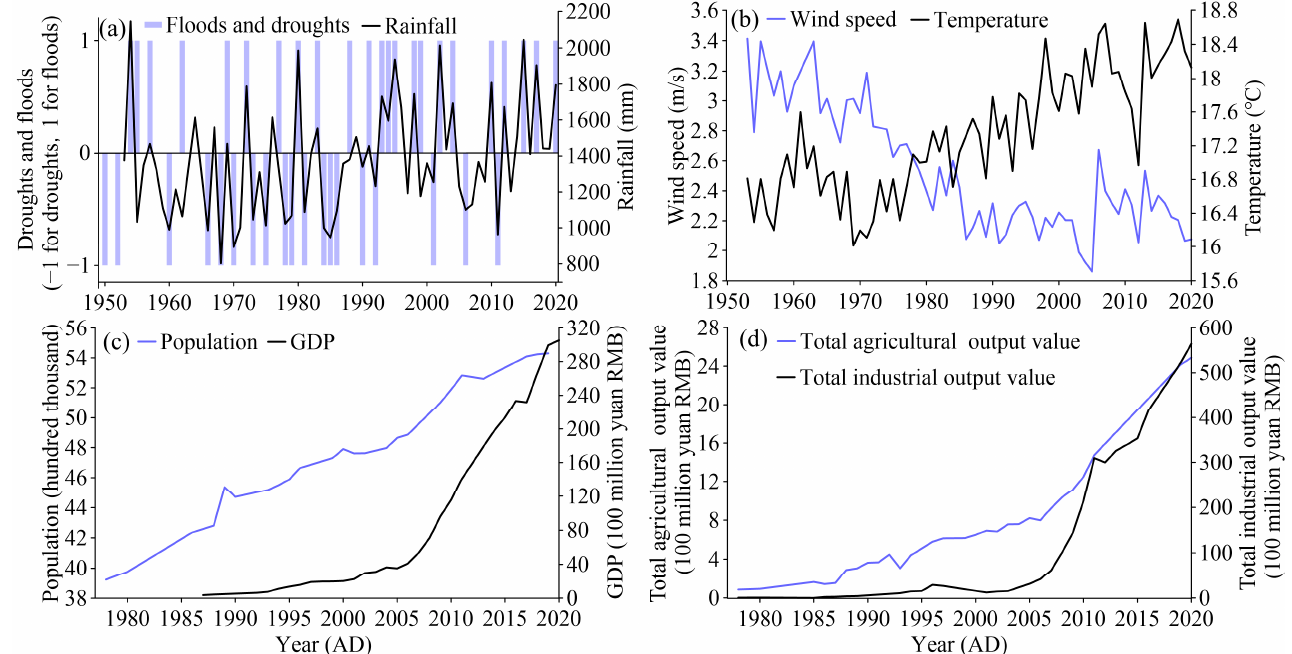
Figure 2. Historical records for the Huanggai Lake Basin. The records include ( a ) rainfall, flood, and drought data; ( b ) temperature and wind speed data; ( c ) population and GDP data; ( d ) total agricultural output value and total industrial output value.